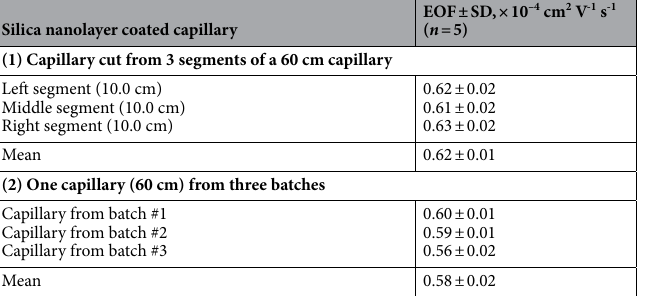
Table 3. EOF mobilities of silica nanolayer coated capillaries: (1) a single coated capillary cut into three segments (left, middle, right); (2) one capillary selected from three batches. Measured EOF mobility of non- coated capillary (60.0 cm length) is 1.26 ± 0.01 cm 2 V -1 s -1 ( n = 5).